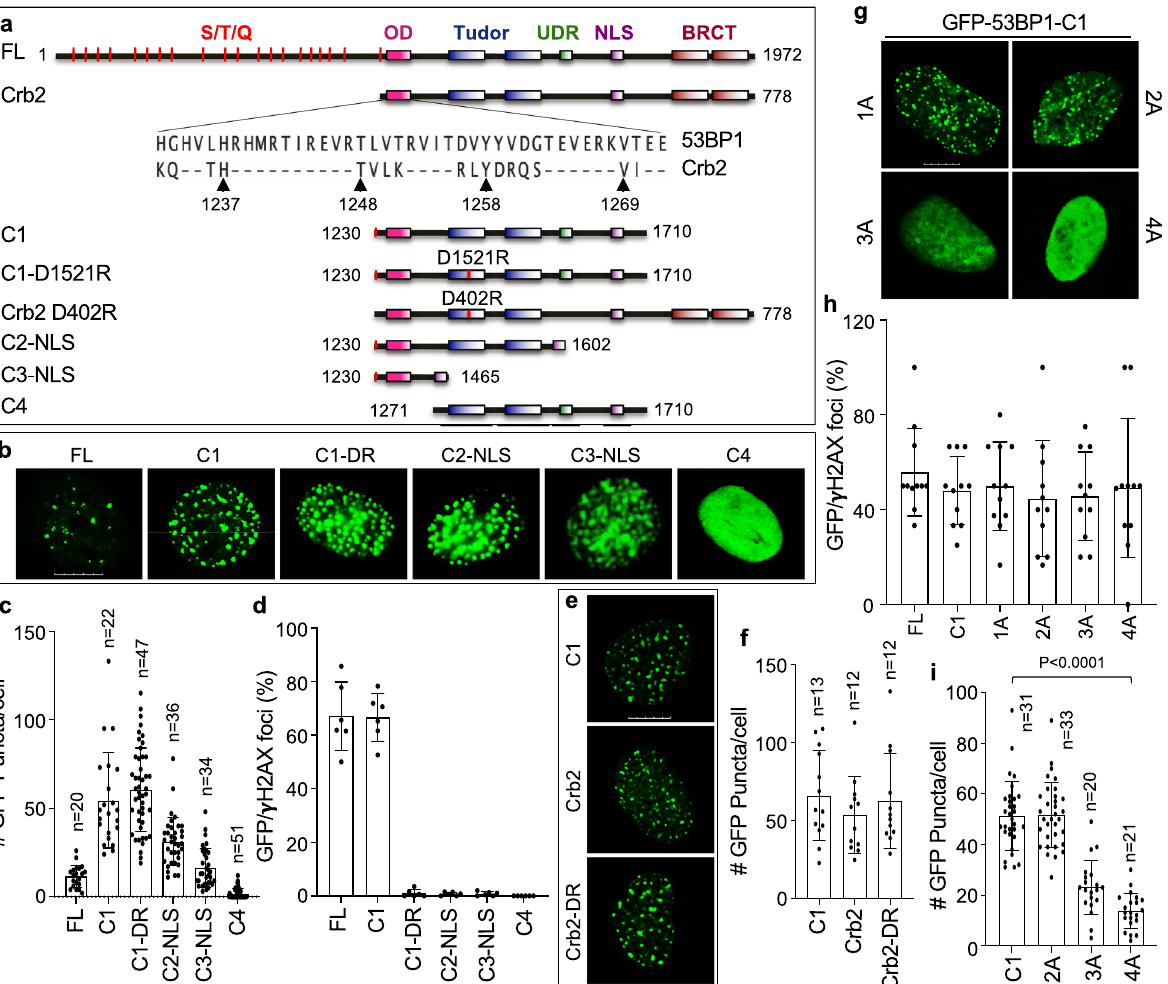
Fig. 6 Domains and residues of 53BP1 involved in LLPS and DSB repair. a Schematic diagram for mutant generation and alignment of the OD between 53BP1 and Crb2. Conserved residues (H1237, T1248, Y1258, and V1269 in human 53BP1) in the OD are indicated by arrowheads. b Representative single z-plane confocal images of 53BP1 puncta formed by different constructs in U-2 OS cells in the absence of DNA damage. c Puncta number of GFP-53BP1 constructs analyzed from indicated number of cells from two independent experiments. d U-2 OS cells were transfected with GFP-53BP1 constructs for 48 h, irradiated with 5 Gy of IR, fi xed 4 h later and stained with anti- γ H2AX antibodies. The percentage of cells showing co-localizing foci for GFP and γ H2AX over total GFP positive cells was assessed from n = 6 biological replicates acquired from two independent experiments. e Representative single z-plane confocal images of puncta formed by GFP-53BP1-C1, GFP-Crb2, and GFP-Crb2/D402R in U-2 OS cells in the absence of DNA damage. f Puncta number of GFP-53BP1-C1, GFP-Crb2, and GFP-Crb2/D402R analyzed from indicated number of cells from two independent experiments. g Representative single z-plane confocal images for puncta formed by GFP-53BP1-C1/OD mutants in U-2 OS cells in the absence of DNA damage. 1A-4A indicates Ala substitution at the four conserved OD residues. h U-2 OS cells were transfected with GFP-53BP1 constructs for 48 h, treated with 3.5 μ M bleomycin for 6 h, fi xed, and stained with anti- γ H2AX antibodies. The percentage of cells showing co-localizing foci for GFP and γ H2AX over total GFP positive cells was assessed from n = 11 images from two independent experiments. i Puncta number of cells in ( g ) in the absence of DNA damage was analyzed from indicated number of cells. Data represent mean values and SD in ( c ), ( d ), ( f ), ( h ) and ( i ). Scale bar is 10 μ m. Unpaired two-tailed t test was performed in Prism 9.0 with 95% con fi dence intervals in ( i